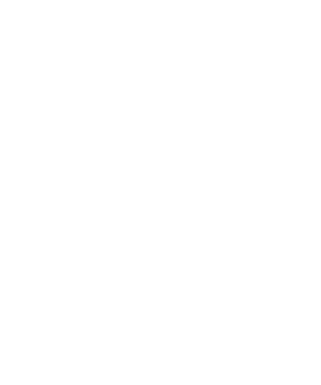
FIGURE 3 | The curve of glucose infusion rate. The fi gure shows that the serum glucose concentrations of the three different injection sites were basically the same as the target blood glucose, and the blood glucose level within 3 h was basically maintained at the target blood glucose level. As can be seen from the fi gure, the glucose infusion rate curves of the abdomen, upper arm, and thigh were basically the same after injection.